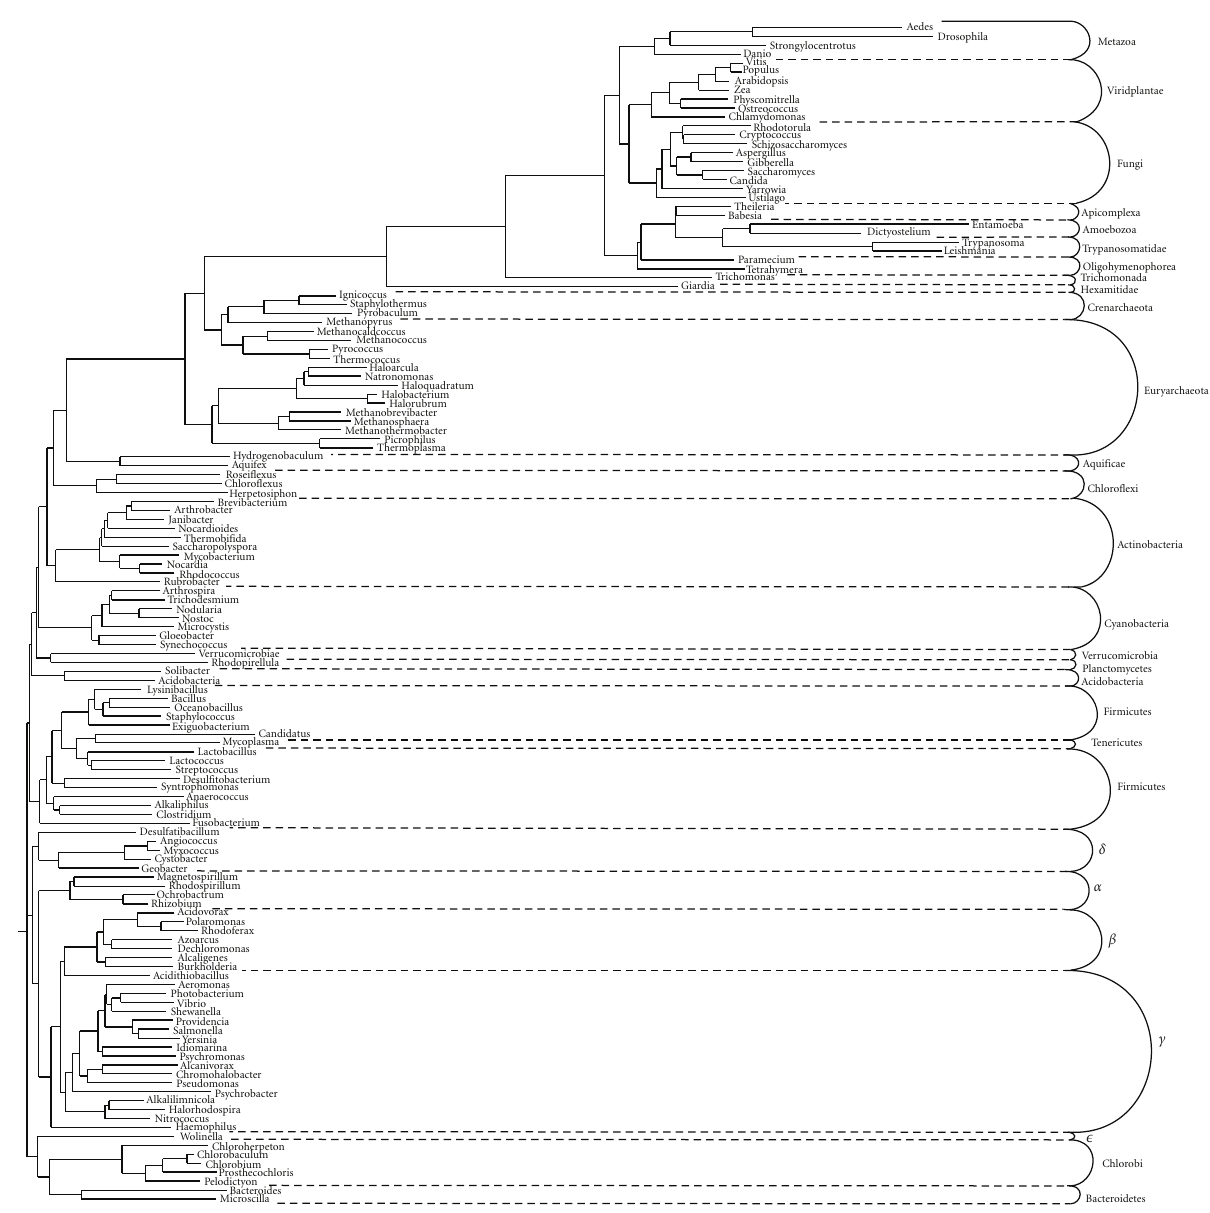
Figure 5: Phylogenetic tree of 16S and 18S rRNA nucleotide sequences of genera represented in this study. The methodology was as described in Figure 1. Sequences were derived from the NCBI nucleotide database. Clusters correlate with organismal